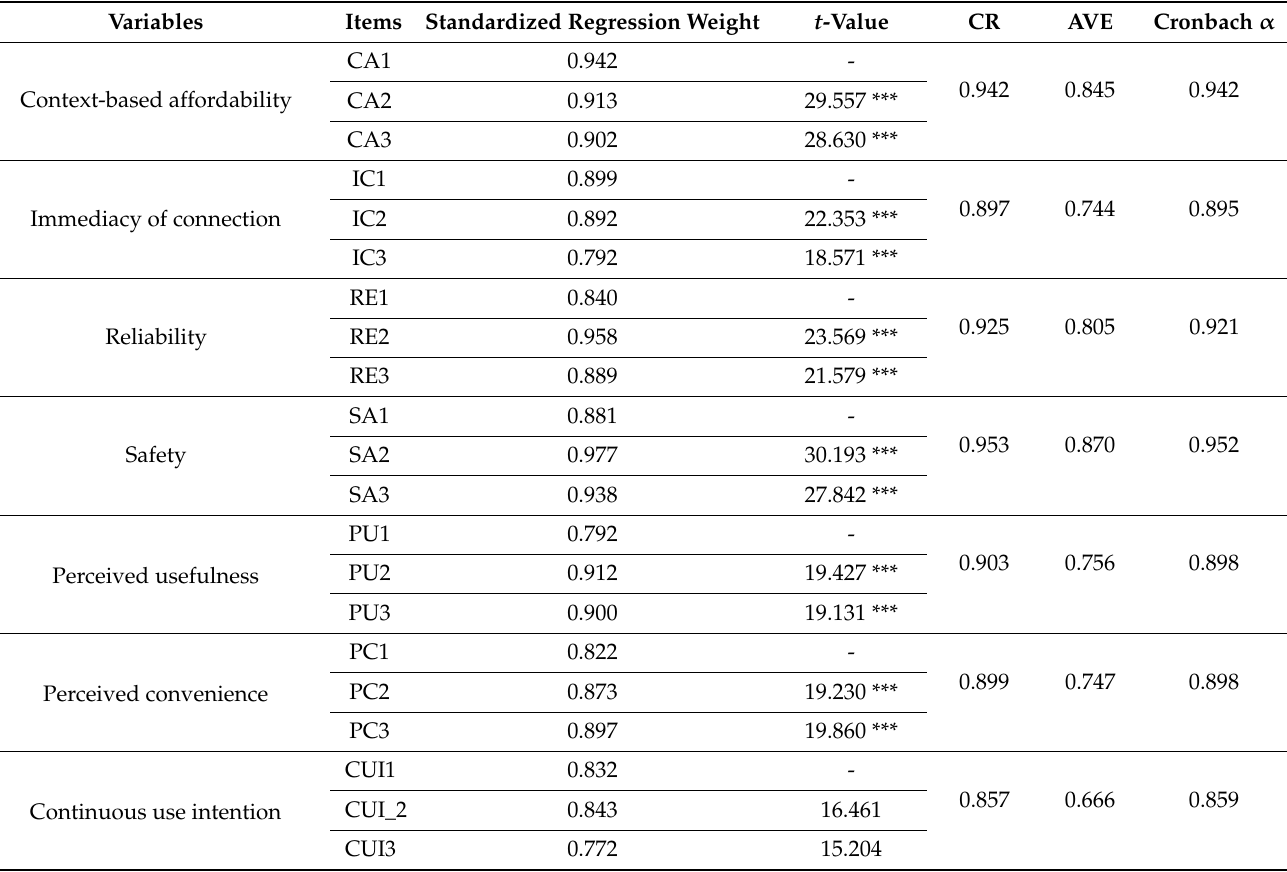
Table 4. Results of reliability and convergent validity test.